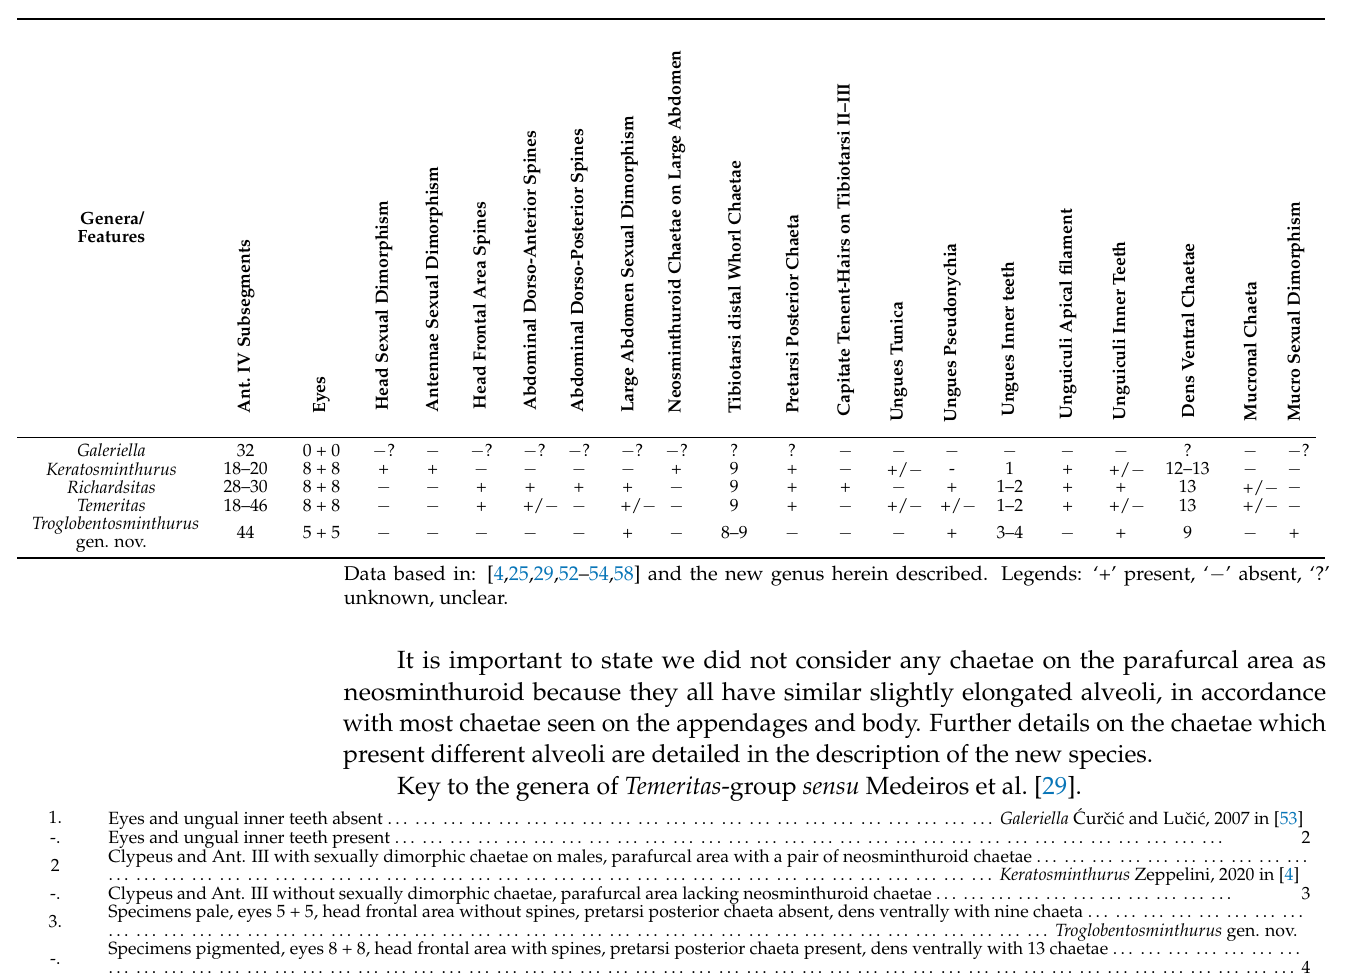
Table 2. Comparison between the genera of the Temeritas -group (updated from